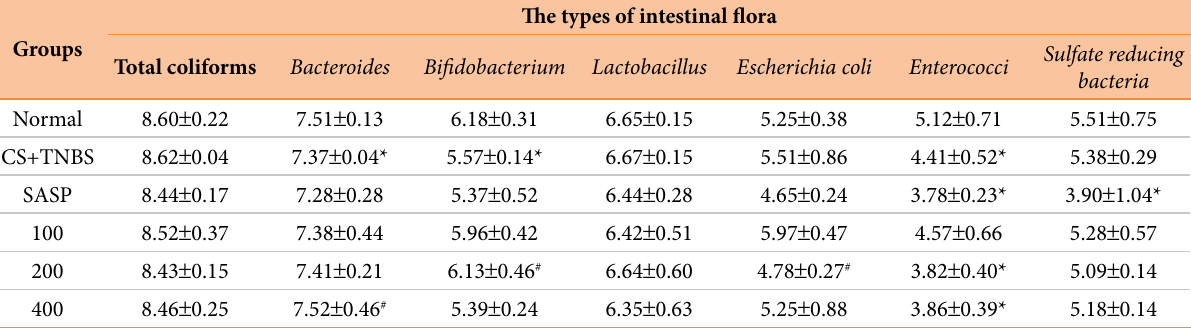
Table 4 - The effect of Periplaneta americana L. on gut microbiota in rats after chronic stress with ulcerative colitis (Lg quantity